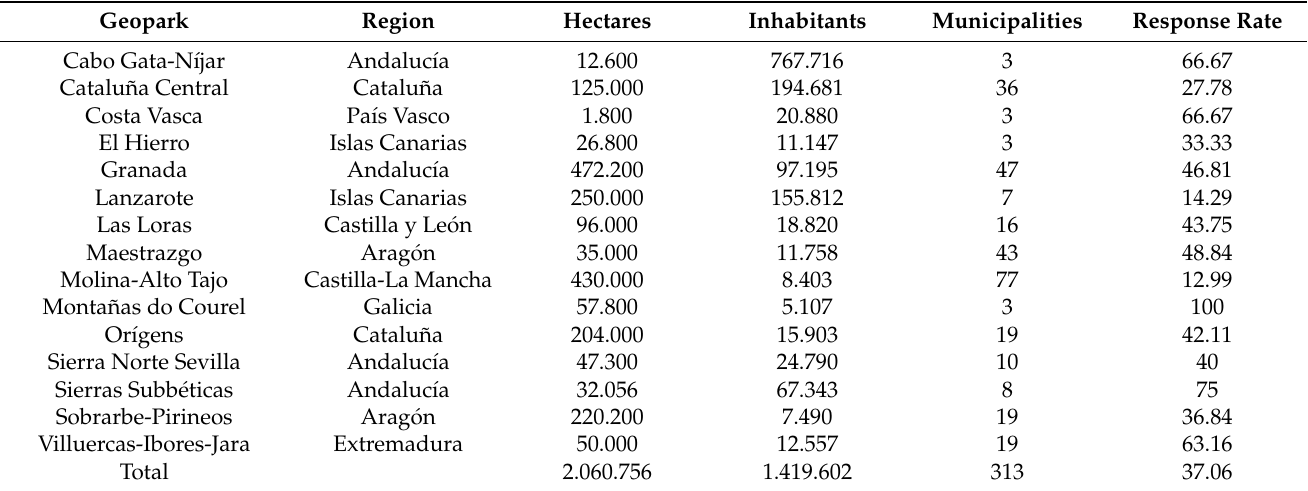
Table 1. Description of the Spanish Geoparks [74,75].